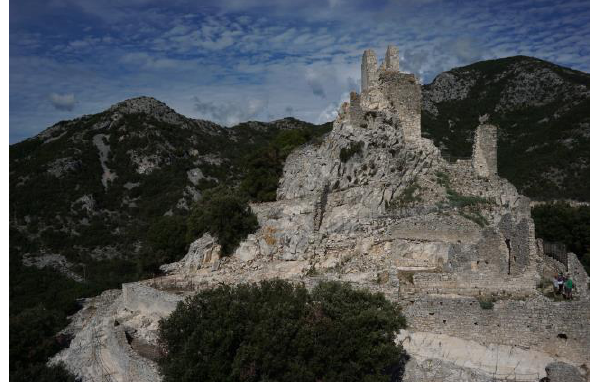
Figure 1. Image from UAV of the Rocca of San Silvestro, Sept.